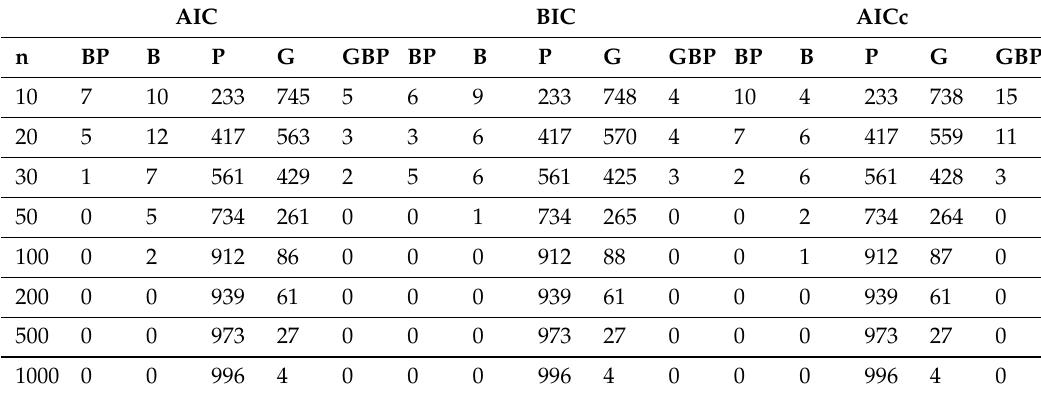
Table 15. Smaller AIC/BIC/AICc scores in 1000 simulations from a censored Pareto distribution P ( k , θ ) with k = 7.5, θ = 0.15.